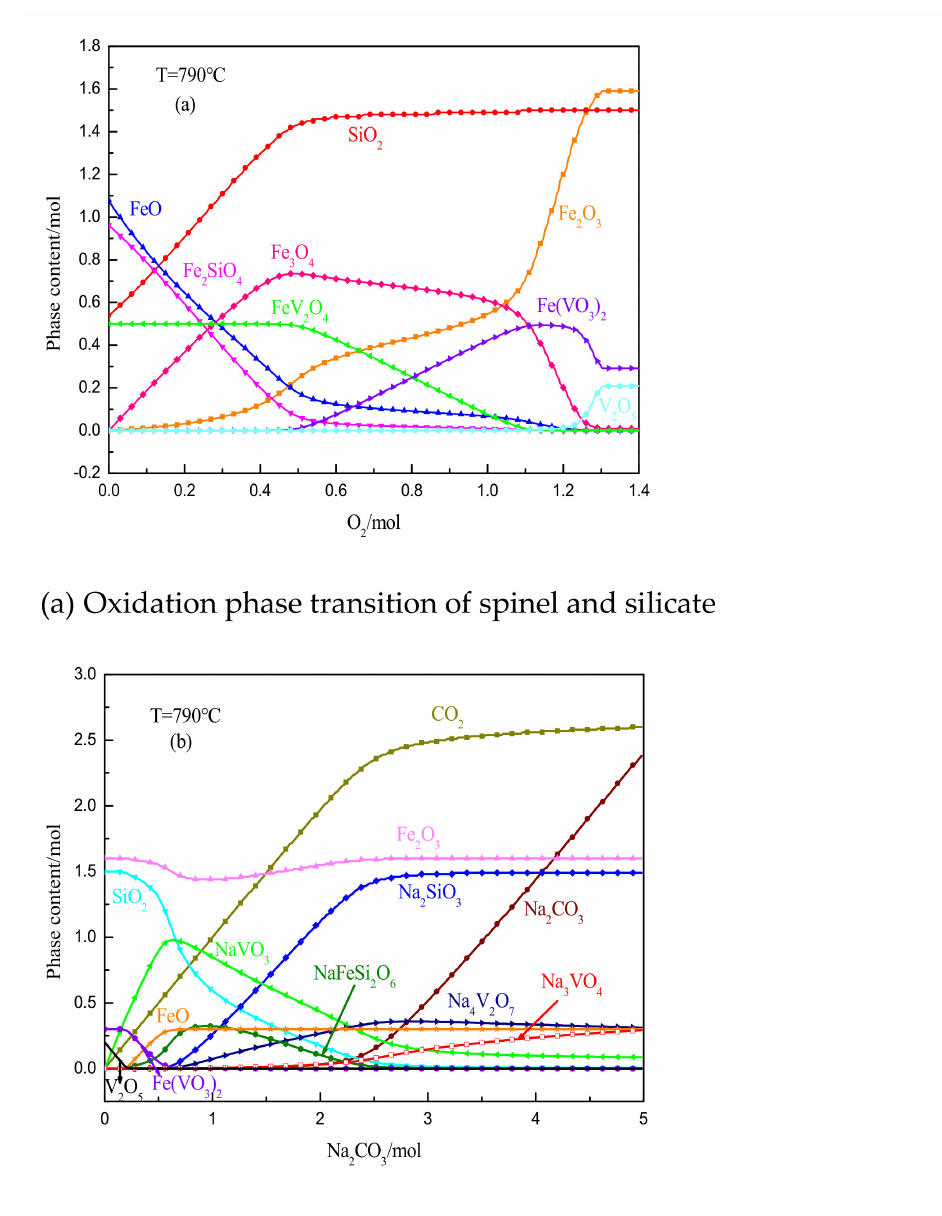
Figure 7. Phase transformation of vanadium slag during sodium roasting. It can be seen from Figure 7b that V 2 O 5 first consumes 0.2 mol of Na 2 CO 3 to form NaVO 3 , while Fe 2 O 3 and SiO 2 , which are reaction pairs of reaction substances, also react with Na 2 CO 3 to form NaFeSi 2 O 6 . When Na 2 CO 3 consumption exceeded 0.2 mol, Fe(VO 3 ) 2 also began to participate in the reaction with Na 2 CO 3 to form NaVO 3 and FeO. When Na 2 CO 3 consumption was 0.5 mol, all V in V 2 O 5 and Fe(VO 3 ) 2 were transferred to V of NaVO 3 , and the environment of V atoms was changed. Later, with the continuous increase of consumption of Na 2 CO 3 , NaVO 3 combined with Na 2 CO 3 to form Na 3 VO 4 and Na 4 V 2 O 7 . As an intermediate product, NaFeSi 2 O 6 shows a tendency to increase first and then decrease. This is due to the combination of Na 2 CO 3 and NaFeSi 2 O 6 to form more stable Na 2 SiO 3 and Fe 2 O 3 , at the same time, the formation of NaFeSi 2 O 6 also proves that when vanadium slag is roasted at 790 ◦ C, 20% Na 2 CO 3 is appropriate. In the phase